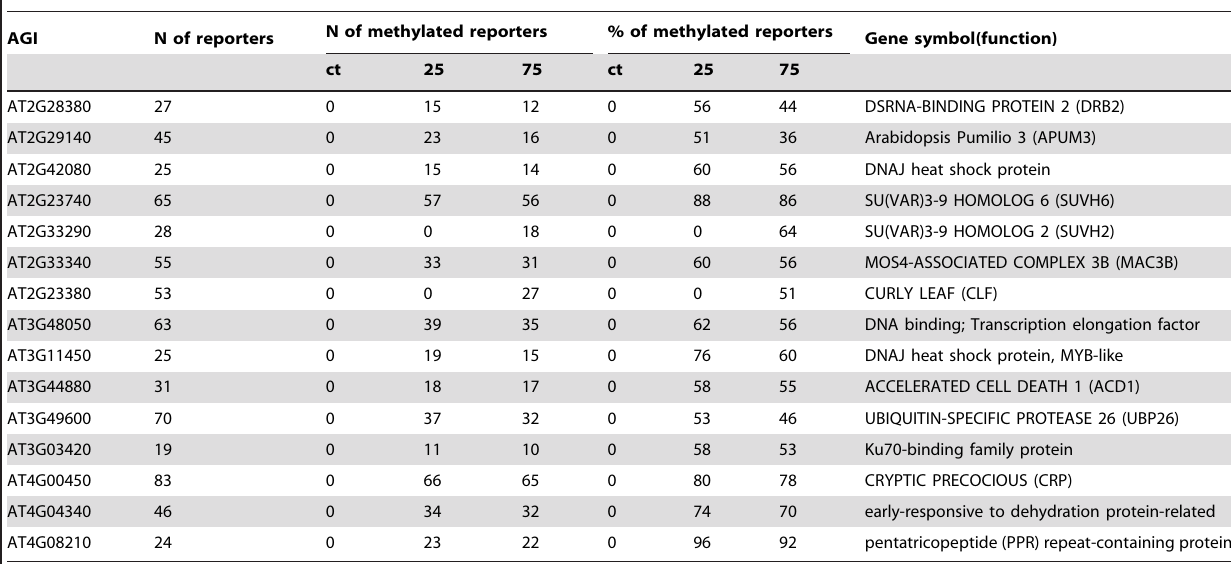
Table 3. Genes hypermethylated in the progeny of stressed plants.